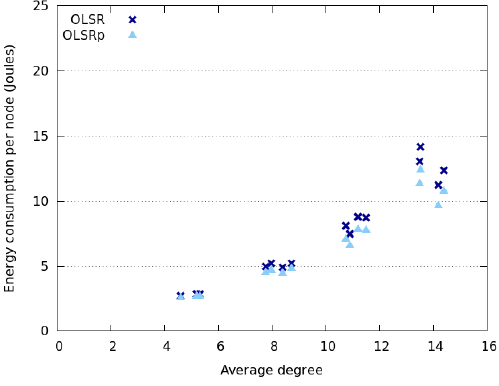
Figure 11. Energy consumption versus network degree when nodes follow a RPGM